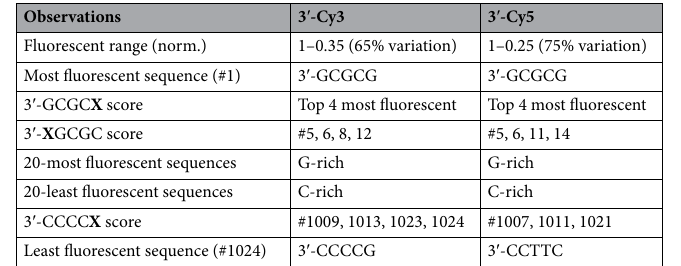
Table 2. Summary of the most relevant findings and observations in the sequence-dependence of 3 ʹ -Cy3 and 3-Cy5 labeled single-stranded